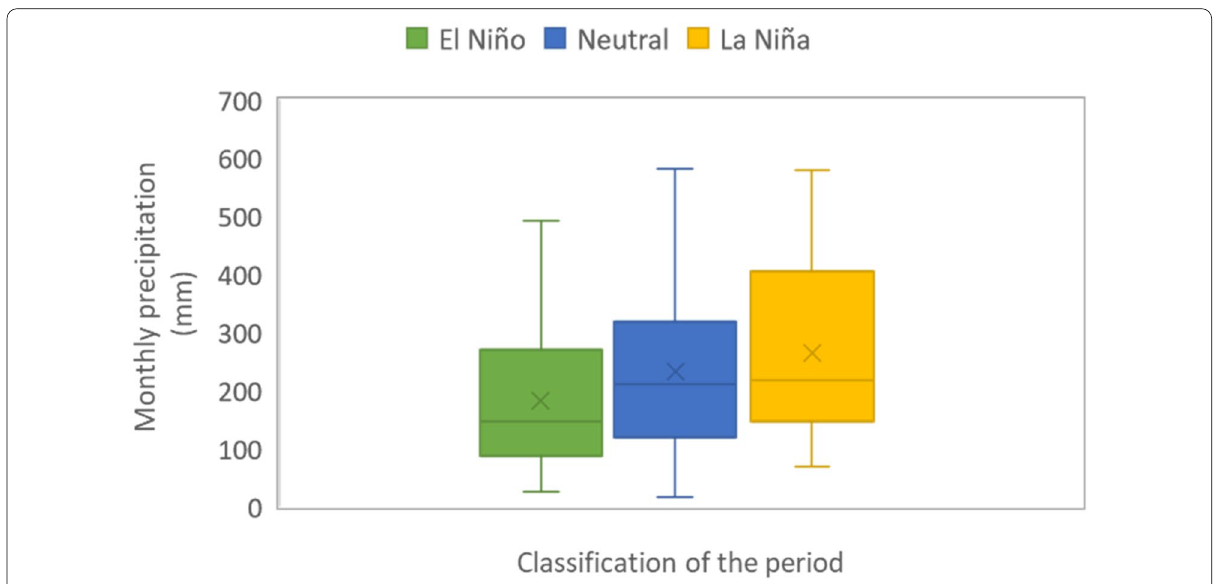
Fig. 6 Distribution of the monthly precipitation as a function of the classification of the period